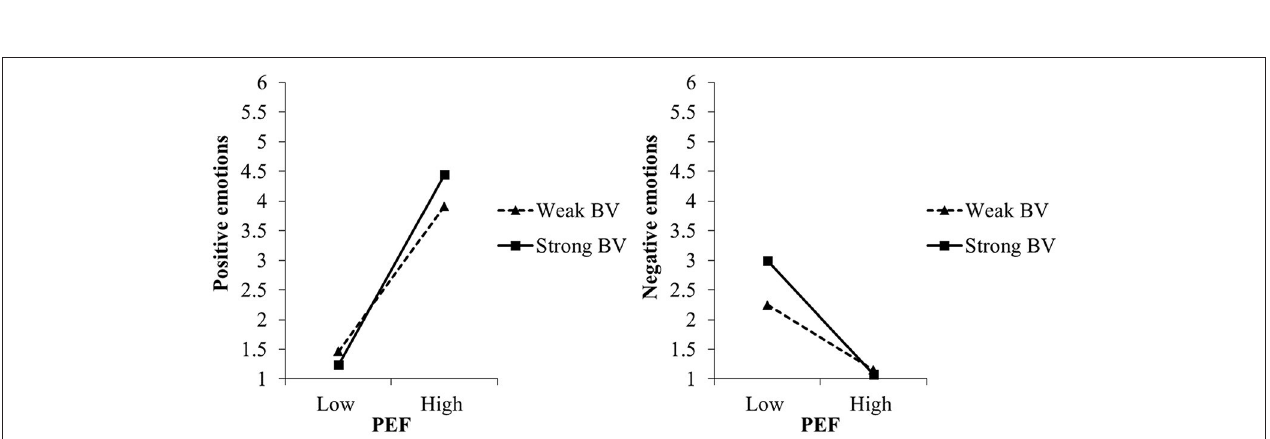
FIGURE 5 | Moderating effect of biospheric values (BV) on the relation between perceived environmental friendliness (PEF) of and positive and negative emotions toward nanophotonic lightbulbs in experiment II, study 1. For the simple slope analyses, we used the estimates of step 2 of the regression analyses (c.f. Table 2 ).